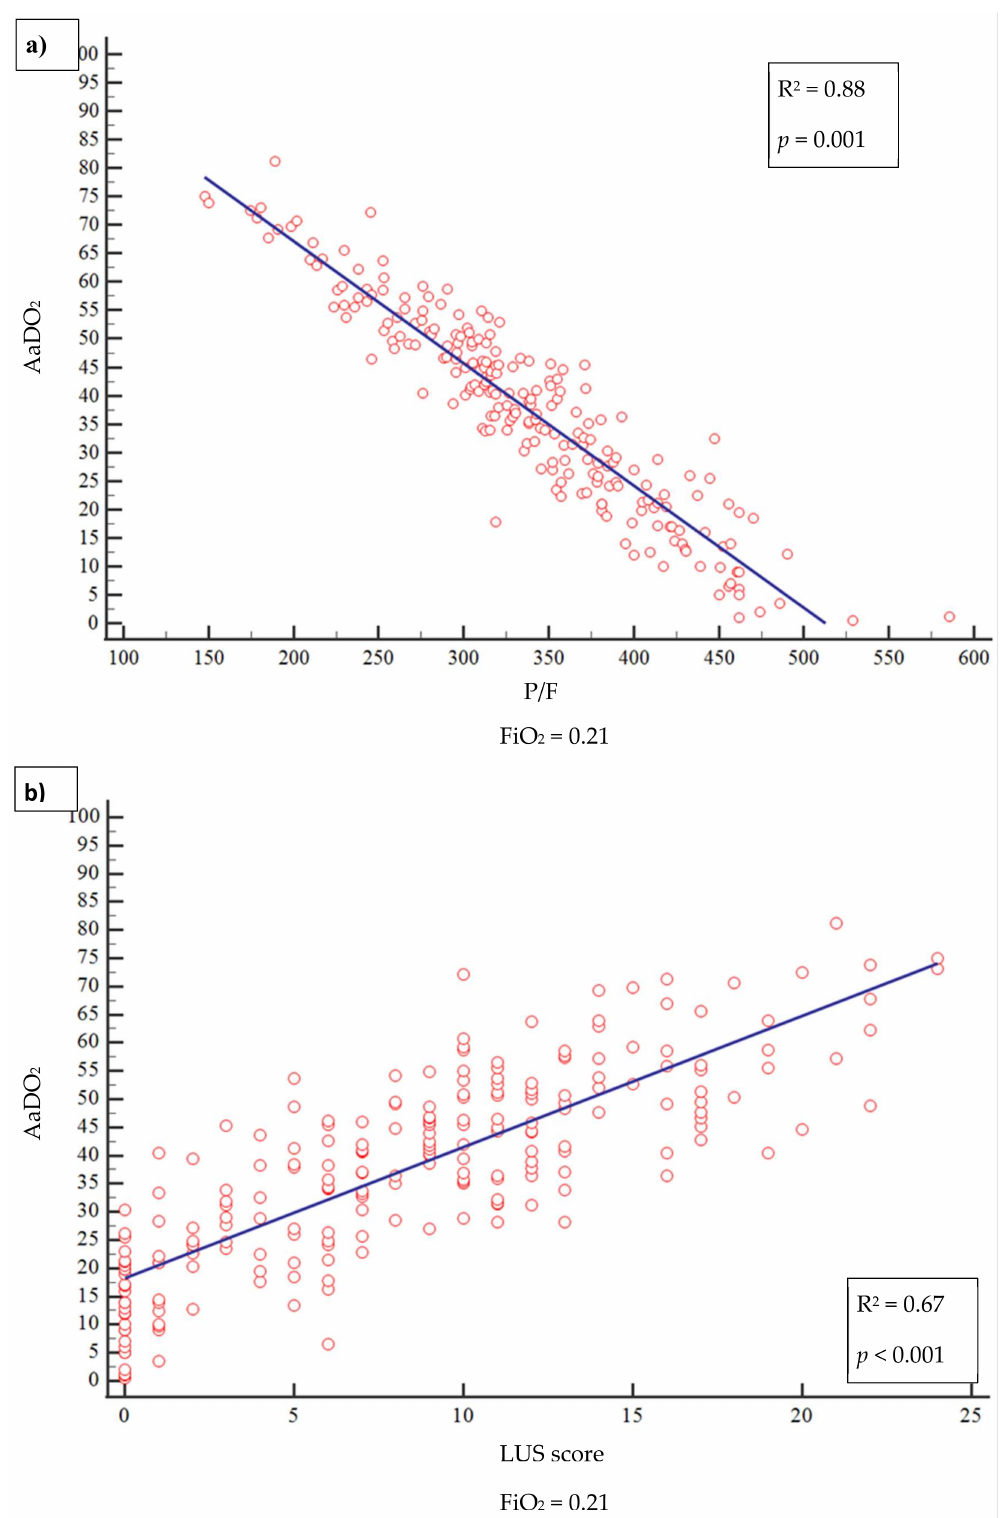
Figure 1. ( a ) relationship between AaDO2 and P/F and ( b ) between AaDO2 and